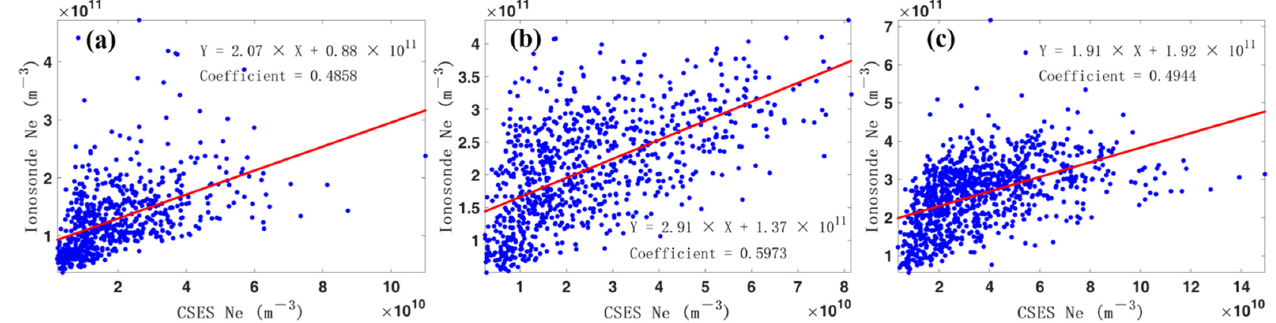
Figure 6. Ne scatters for CSES and ionosonde. Panels ( a – c ) are for Leshan, Tengchong and Puer stations, respectively. In each panel, the red line is the linear fitting line.